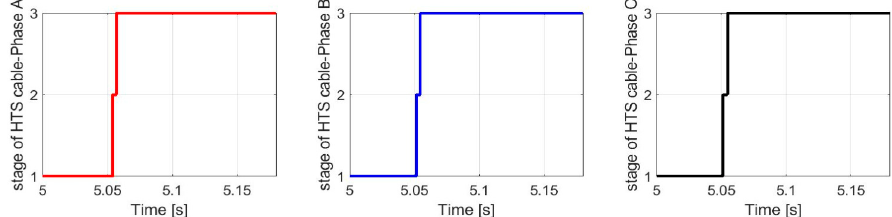
Figure 7. Stages of quenching process for phase A, B, and C for 3-Phase-to-ground solid fault at 50% of cable’s length.